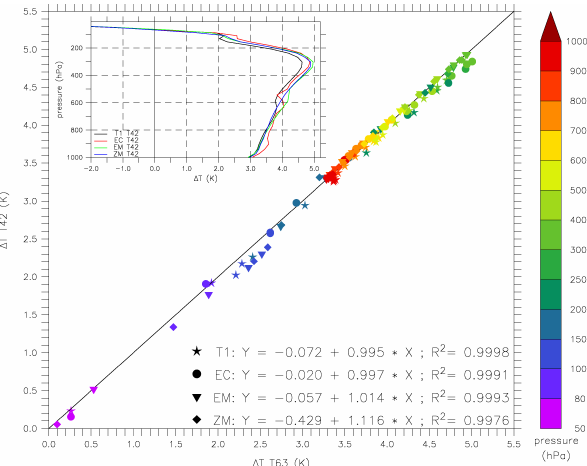
Figure 2. Correlation of the temperature change 1T between the resolutions T63 (horizontal axis) and T42 (vertical axis) for the indi- vidual simulations distinguished by symbols (T1=star, EC=circle, EM=triangle and ZM=diamond) and colour coded with pressure altitude. The inner panel shows the temperature increase 1T for the coarser resolution (T42), the same as Fig. 1c. The black line depicts the one-to-one